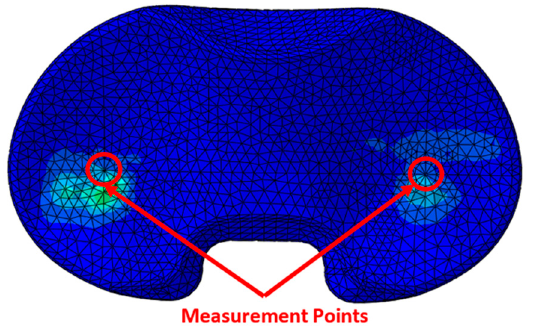
Figure 1. Measurements points concerning the extraction of the contact pressure values.